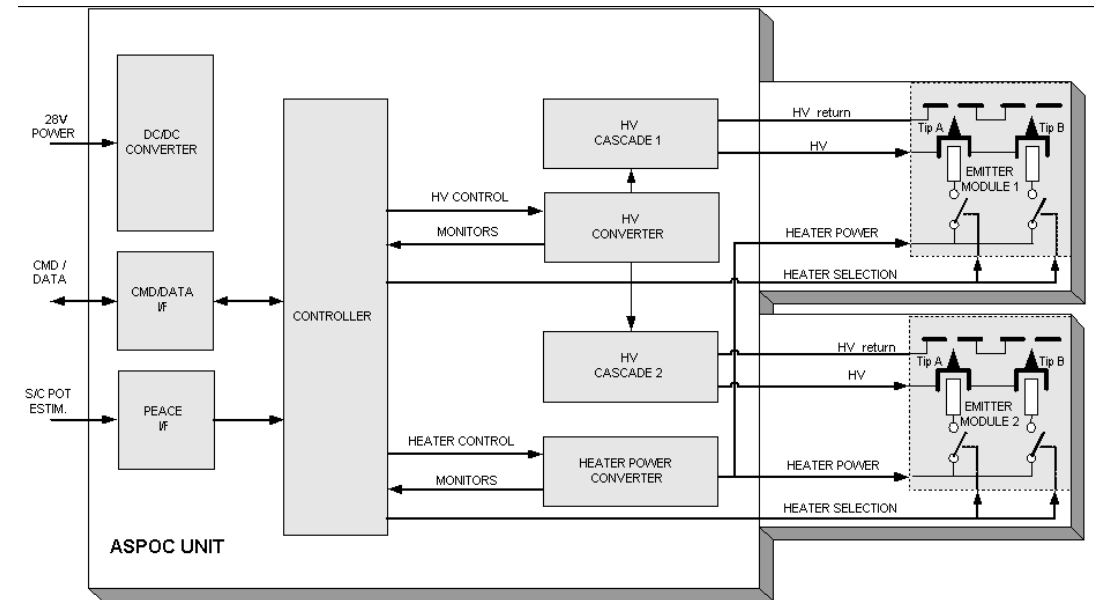
Fig. 6. Electric block diagram of Double Star ASPOC.